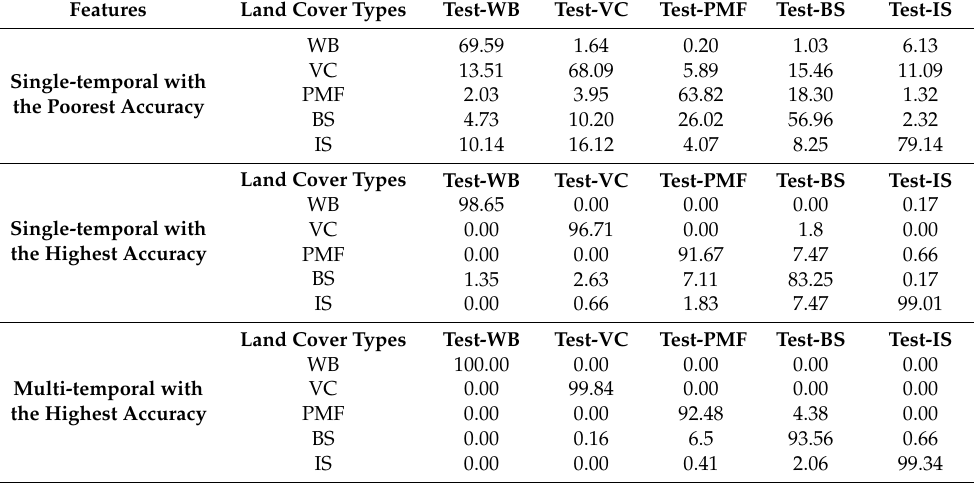
Multi-temporal with the Highest Accuracy